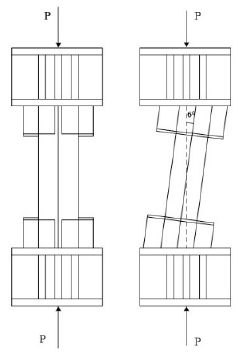
Figure 4. Vertical and slantwise positioning of the specimens.